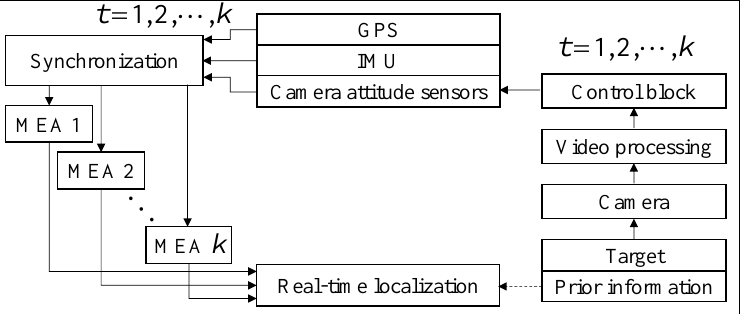
Figure 1. Target localization workflow. and north directions, respectively, which together with axis